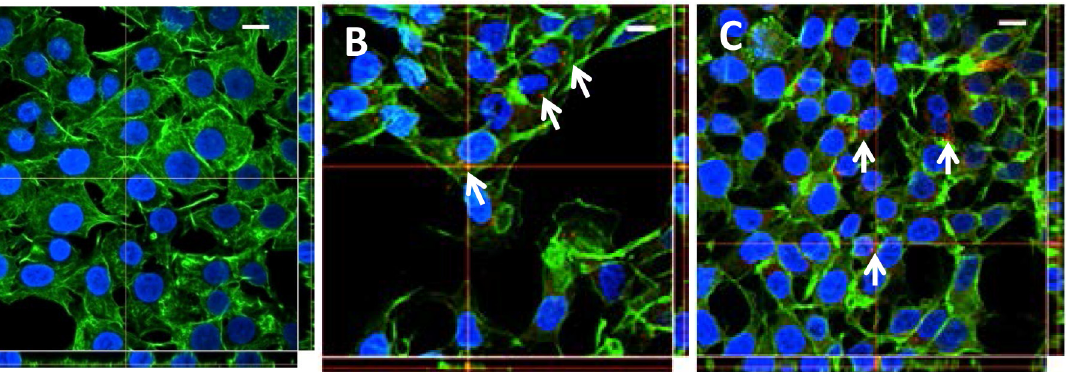
Fig 8. V . cholerae OMVs internalization into HCT8 cells. OMVs from the wild type strain C6706 and the prtV mutant were labeled with PKH26 red fluorescence marker and subsequently the HCT8 cells were treated for 6 hrs with buffer (A), PKH26-labeled OMVs from V . cholerae wild type strain C6706 (B) or with OMVs from the prtV mutant (C). After the treatment, cells were fixed and actin filaments and nuclei were stained with phalloidin and DAPI, respectively. Internalized OMVs are indicated with white arrows. Confocal Z-stack projections are shown in all images. The crosshairs indicate the positions of the xz and yz planes. Bars represent 10 μ